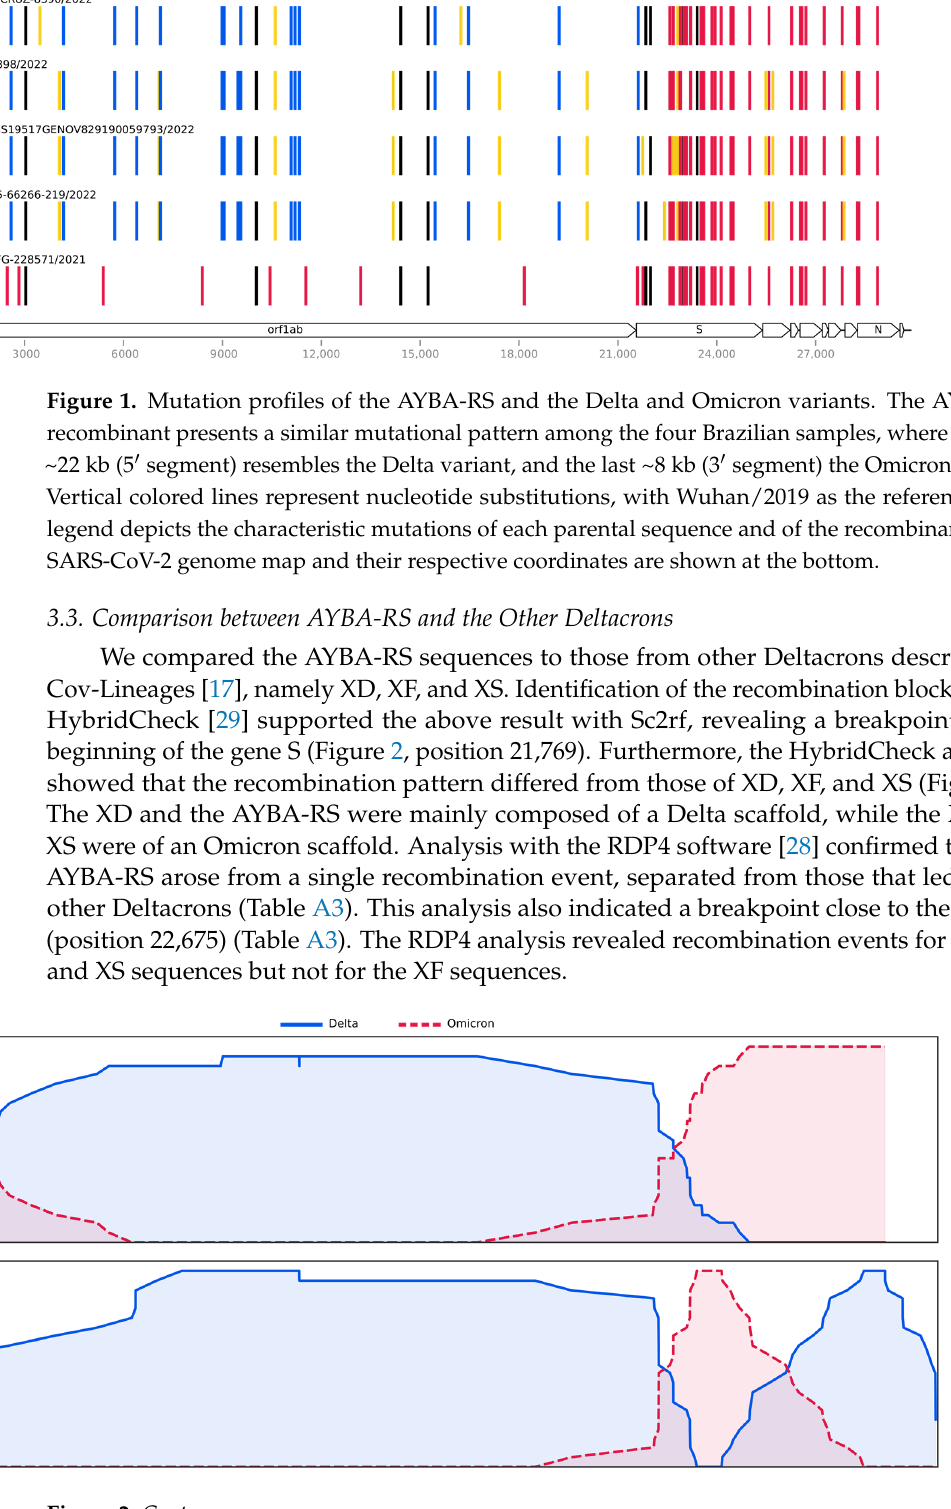
Figure 2. Comparison of the recombination patterns of the AYBA-RS Deltacron and the Deltacrons XD, XF, and XS. Similarity values between the recombinant and the Delta and Omicron parental sequences within a window length of 20 nucleotides along the genome. The legend describes the reference of each comparison. The recombination breakpoints, i.e., points where the lines cross over each other, are distinct for each of the recombinants, and this supports our conclusion of their independent evolution. Recombination plots generated with HybridCheck [29]. Sequences analysed in this plot: Brazil/RS-FIOCRUZ-8390/2022 (AYBA-RS), Brazil/SC-FIOCRUZ-43556-R2/2021 (Delta) and USA/CA-OC-FG-228571/2021 (Omicron) as its parental sequences; France/HDF-IPP54794/2022 (XD), Sweden/37524448XXP/2021 (Delta) and Finland/P-1301/2022 (Omicron) as its parental sequences; England/PHEC-YYN8J41/2022 (XF), South Africa/NHLS-UCT-GS-AF27/2021 (Delta) and South Africa/NICD-N28358/2022 (Omicron) as its parental sequences; USA/CO-CDC-FG- 248528/2022 (XS), Latvia/3410639/2021 (Delta) and USA/CA-CDC-FG-223742/2021 (Omicron) as its parental sequences. Similarity at the y-axis refers to percentage sequence similarity at polymorphic sites only. The SARS-CoV-2 genome map and their respective coordinates are shown at the bottom. 3.4. Evolutionary History of Recombinants of VOC Delta and VOC Omicron The phylogenetic network reconstruction and haplotype network analysis were congruent since all four Brazilian recombinant sequences formed a group distinct from the other Deltacrons. Furthermore, both models showed that the Deltacrons were distributed between the Delta and Omicron groups, having additional portions of each lineage (Figure 3A,B). Phylogenetic analyses for each 5 ′ (Delta) and 3 ′ (Omicron) block of the AYBA-RS assigned the 5 ′ segments of the Brazilian Deltacron to the AY.101 clade. This clade was formed only by sequences from Brazil, notably from Santa Catarina (SC), a state from the South region that borders the Rio Grande do Sul (RS) (Figure A5). On the other hand, the